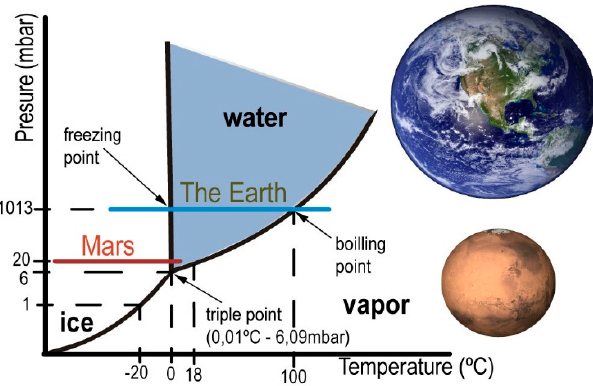
Figure 1. Water phase diagram [14]. Comparison of parameters between Mars and Earth.